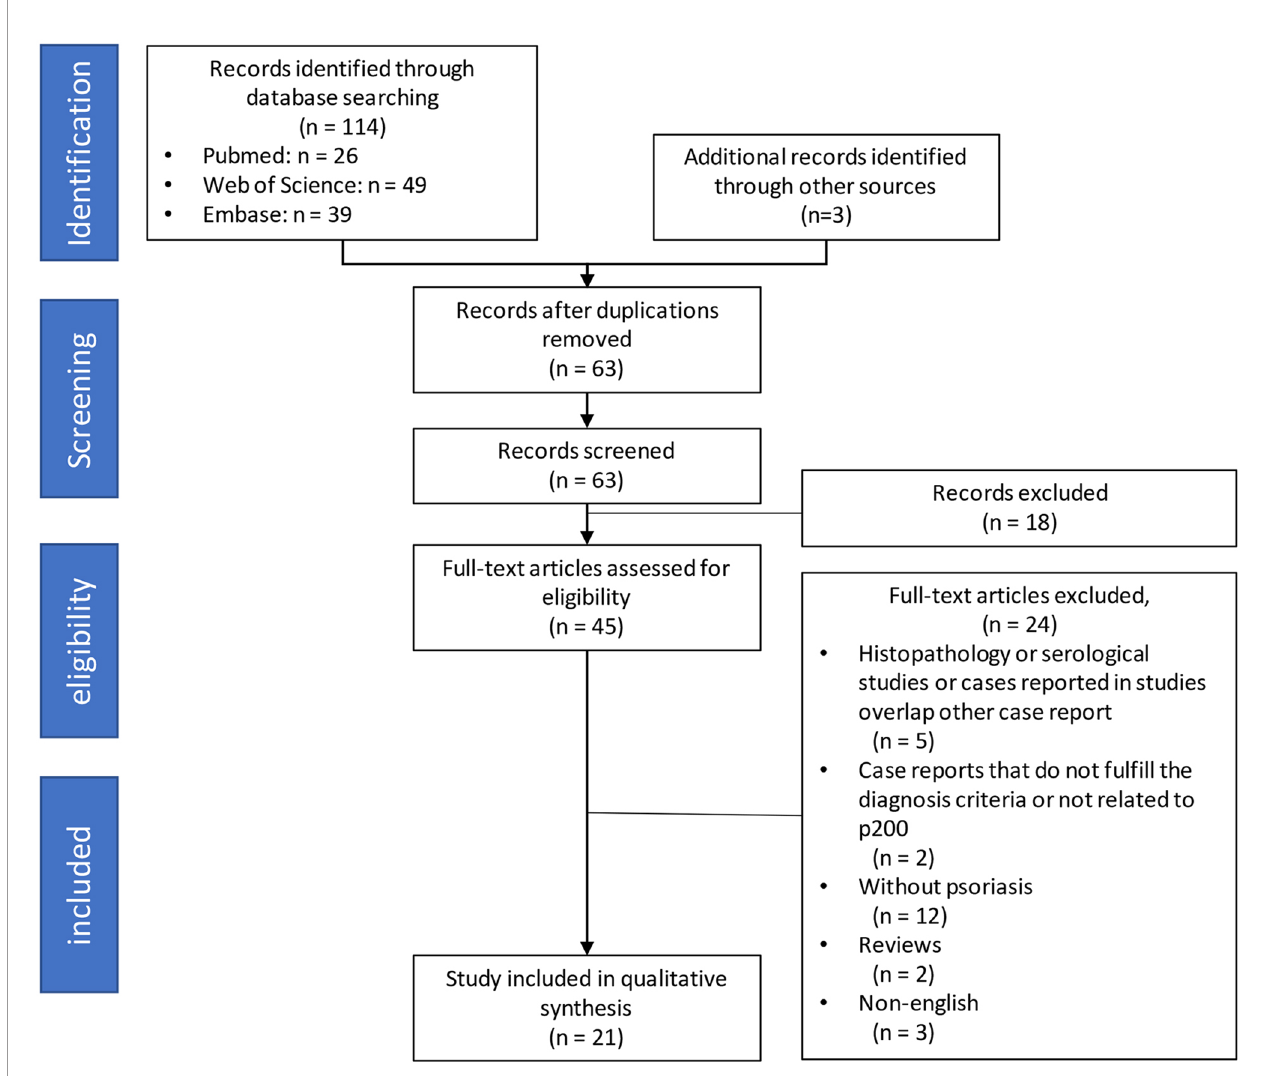
FIGURE 1 | Flow chart for the process of article screening and selection on three